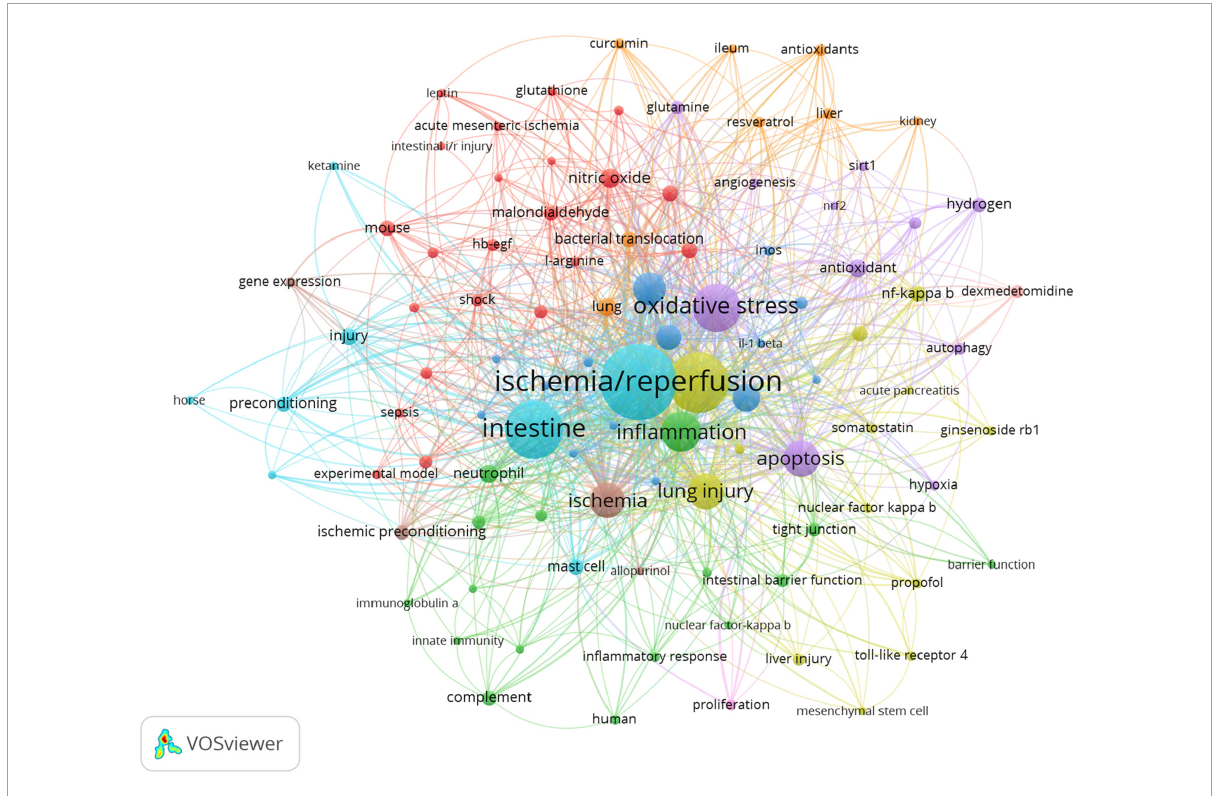
FIGURE8 Keyword co-occurrence network relationship diagram. Ischemia/reperfusion has most co-occurrence with others